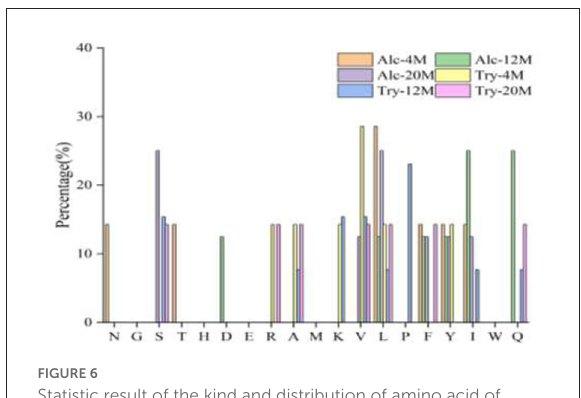
on the bitterness of hydrolysates. This indicated that the peptides with larger molecular weight and free amino acids had higher bitter taste thresholds, so they were not the factor causing the bitterness of the hydrolysates.